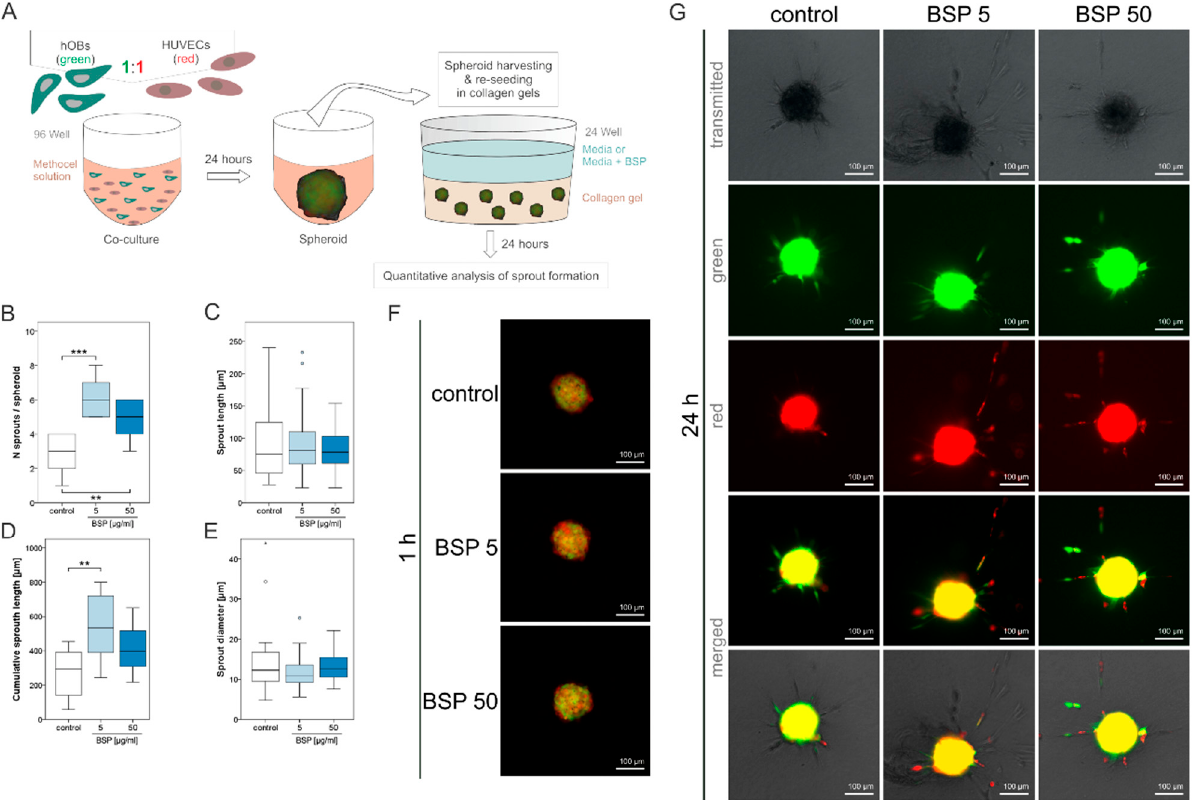
Figure 4. Spheroid model. ( A )—Methodological overview of the spheroid model. ( B )—Number of sprouts counted per spheroid. ( C )—Sprout length. ( D )—Cumulative sprout length. ( E )—Sprout diameter, significant differences are indicated (* p < 0.05, ** p < 0.01, *** p < 0.005) . ( F )—Spheroids